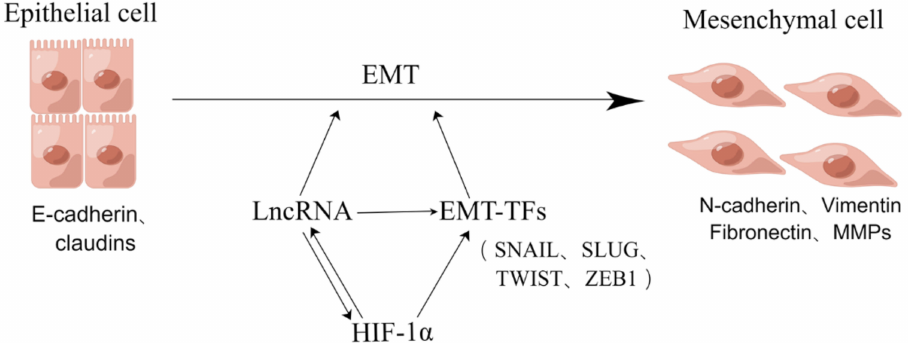
Figure A3. EMT is the process of epithelial-to-mesenchymal transition, during which epithelial markers such as E-cadherin and claudins are decreased, while mesenchymal markers such as vi- mentin, N-cadherin, fibronectin, and MMPs are increased. Hypoxia-induced HIF-1 α can regulate the expression level of lncRNA and form a mutual activation pathway with lncRNA, thereby promoting the production of EMT-TFs and promoting the process of tumor EMT.